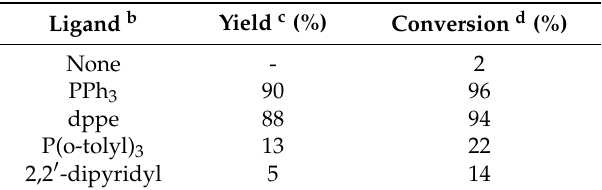
Table 9. Ligand influence on the amination of myrtenyl acetate a ( 1 ) with morpholine in the presence of Et 3 N. Adapted from [124].